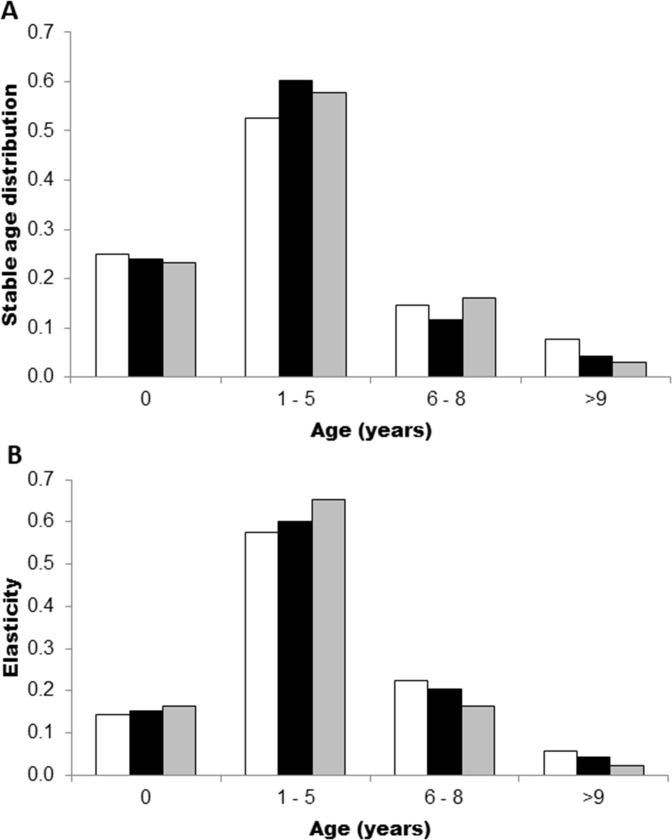
Stable age distribution (a) and elasticity (b) by stage of life cycle of C. porosus. Scenarios are represented by gray (1), white (2) and black (3) columns. Life stages are separated in neonates: 0; juveniles: 1–5 years; adults: 6–8 years, and large adults: >9 years).